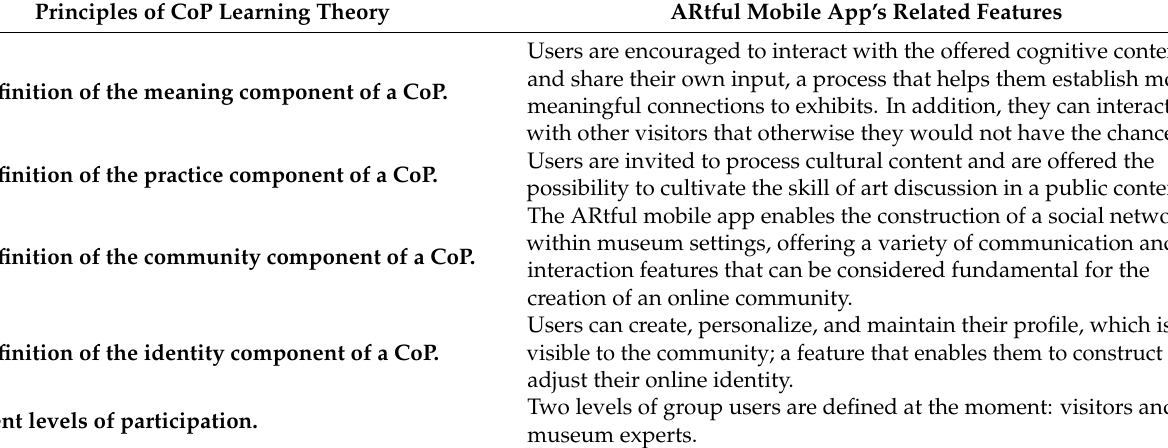
Table 2. Description of how the ARtful mobile app’s design and development was influenced by the key principles of the learning theory CoP.